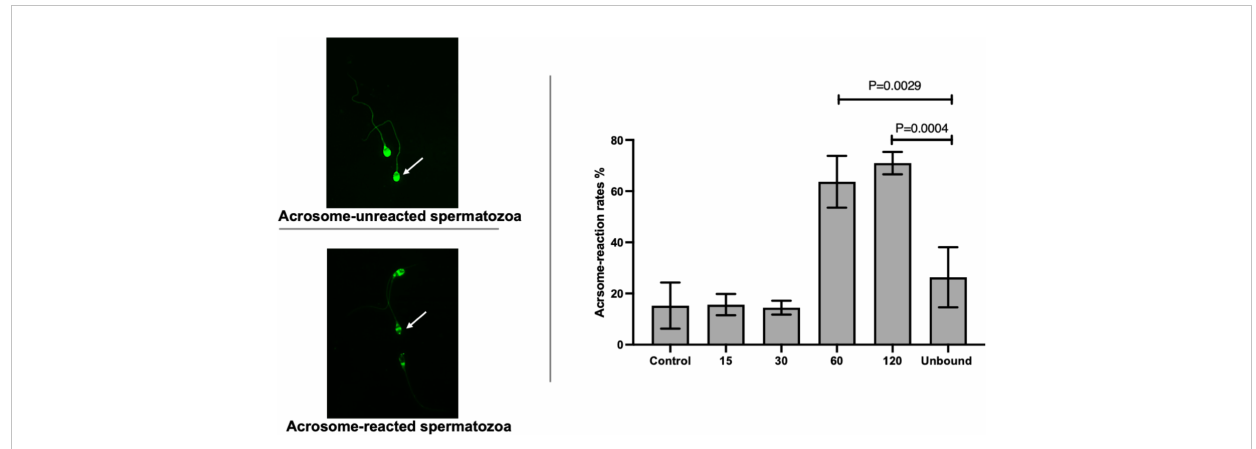
FIGURE 2 Time-course study of acrosome-reaction rates in ZP-bound spermatozoa. Acrosomal status of the control, unbound spermatozoa, ZP-bound spermatozoa (recovered at 15, 30, 60 and 120min) was determined by FITC-PSA. All data are represented as mean ± SD (n=4,